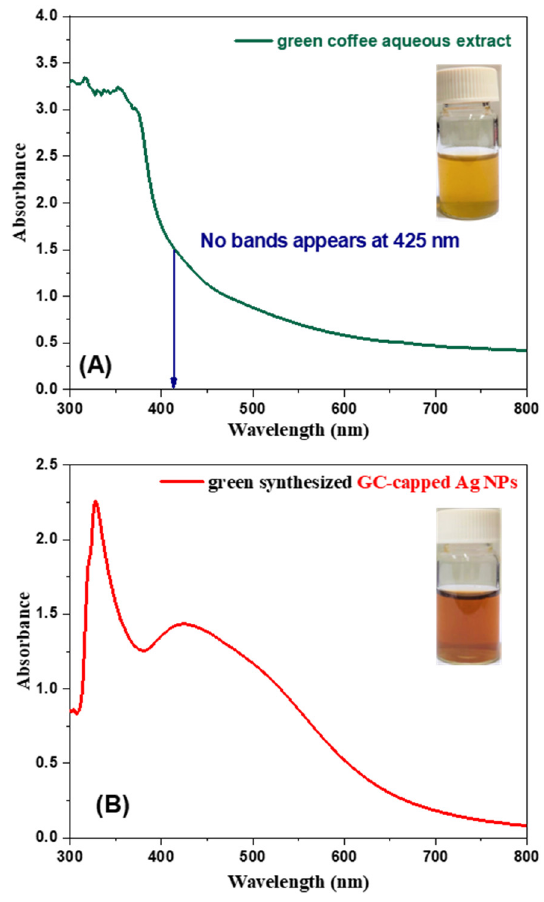
Figure 2. Absorbance spectra of ( A ) aqueous extract of green coffee and ( B ) GC-capped Ag NPs. Insets show photographs of the extract ( A ) and suspension of GC-capped Ag NPs in distilled water ( B ).